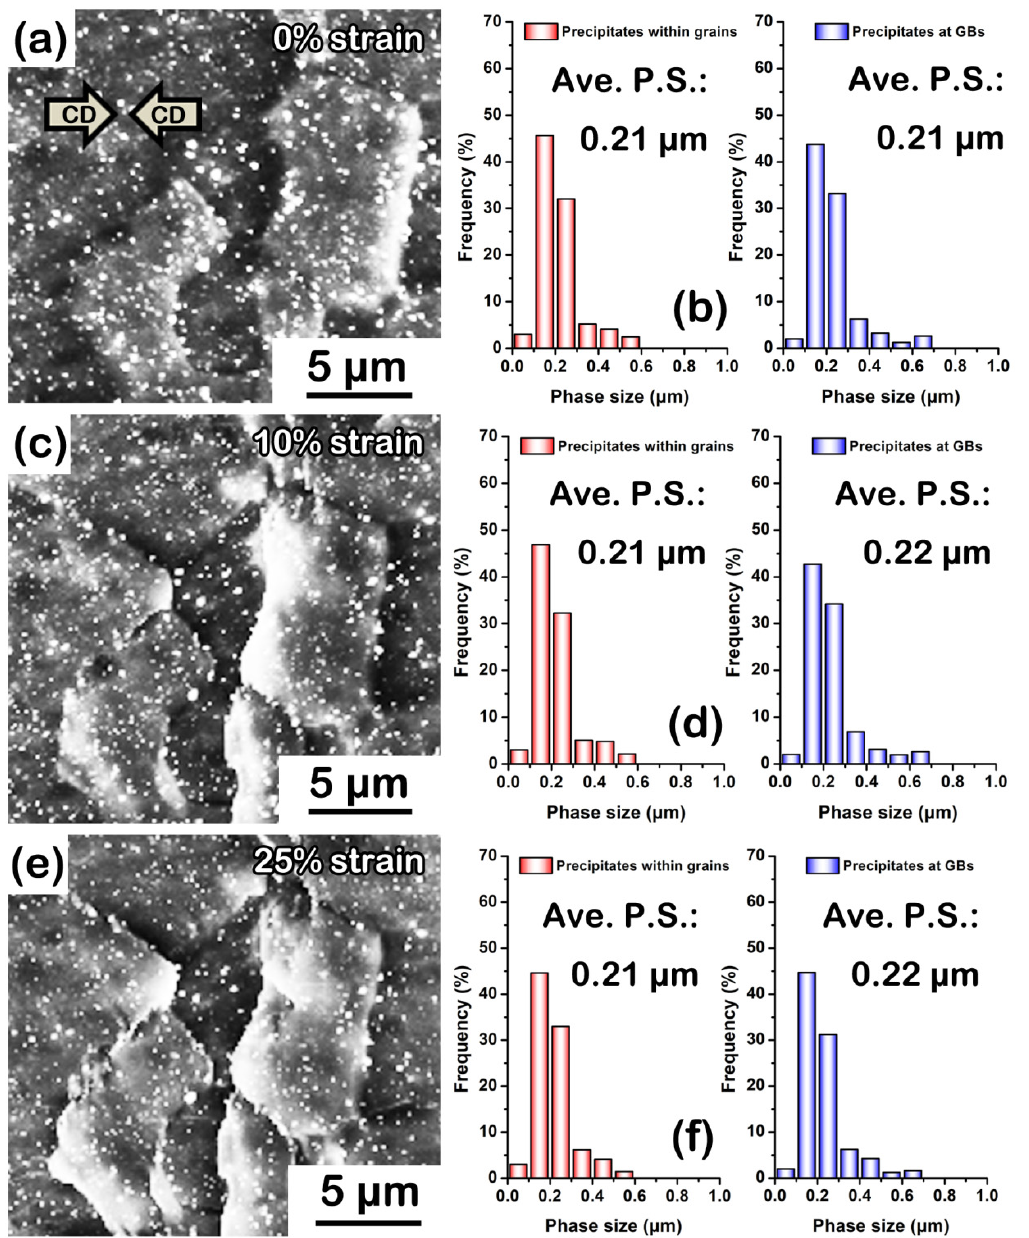
Figure 13. Quasi in situ SEM images and phase size distribution maps of precipitates (including within grains and at grain boundaries) in as-extruded AZB313 alloy after hot compression at 523 K at ( a , b ) 0%, ( c , d ) 10%, and ( e , f ) 25%.